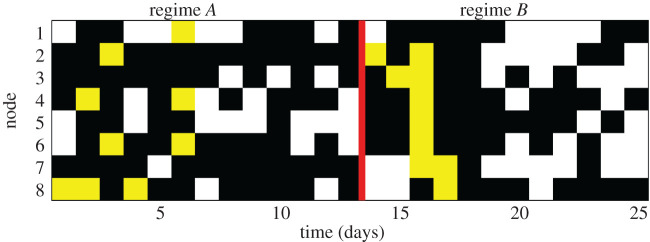
Food dynamics in the network nodes during the 25 days of experiment. Black cells correspond to nodes where food was not present at that day, white regions correspond to nodes which contained food and it was picked up by the ants, and yellow cells correspond to nodes where the food was present but it was not picked up by the ants during the trial. The red line separates the regimes A and B used in our analysis.